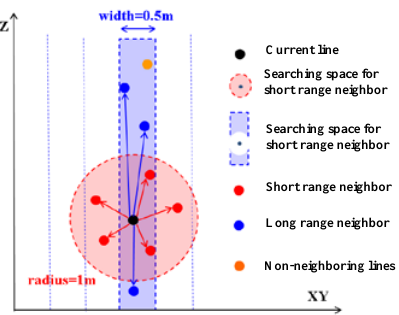
Figure 3. maCRF with short (red) and long (blue)